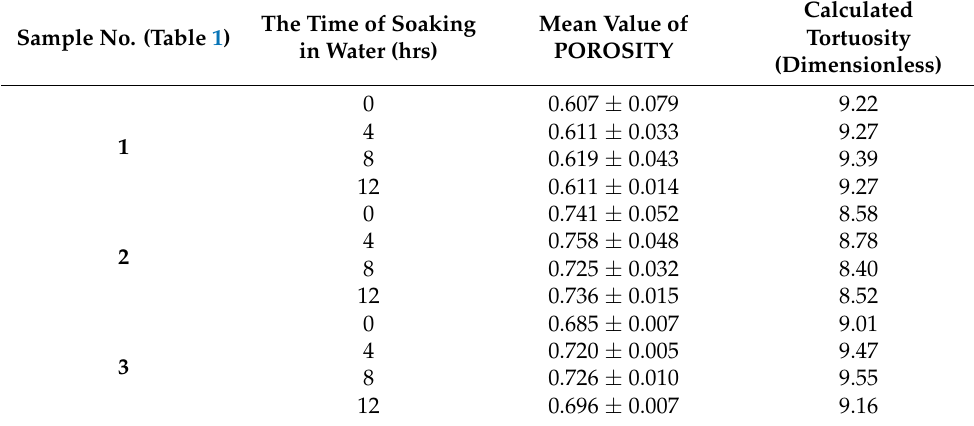
Table 5. The mean values of porosity and tortuosity at different soaking times in water.